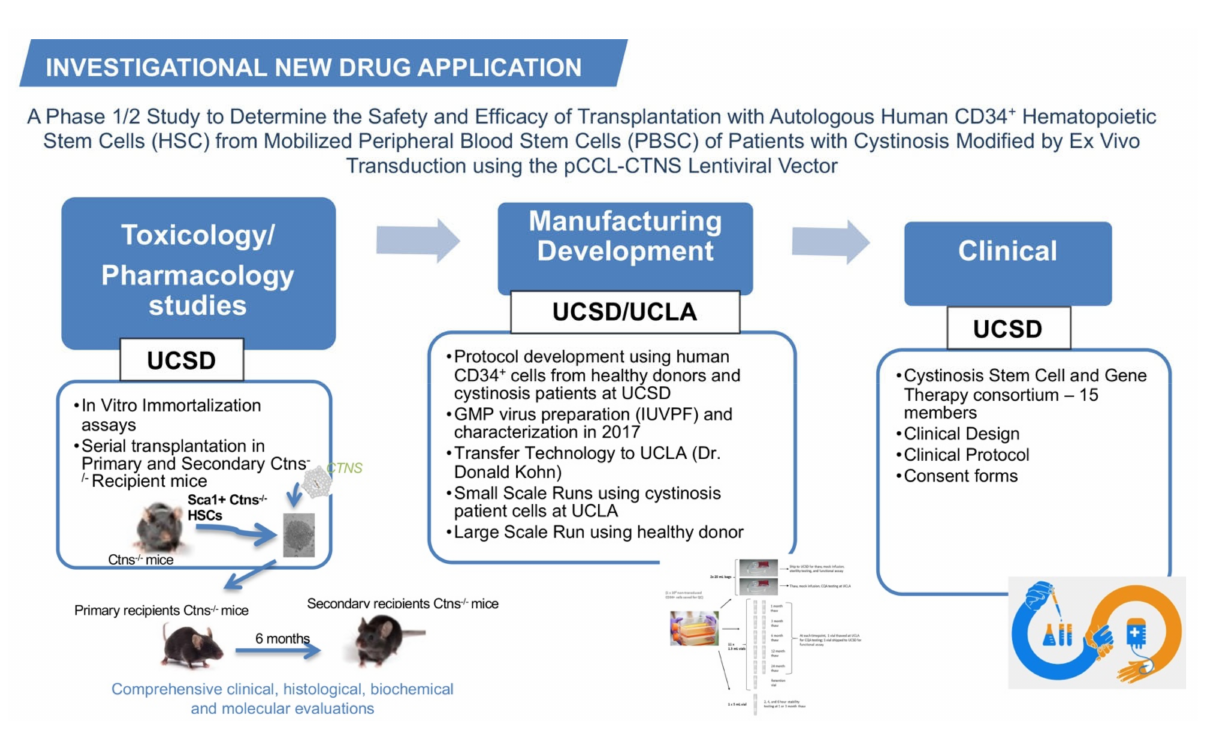
Figure 1. The investigational new drug application for cystinosis. The investigational new drug application contains three main categories, the toxicology/pharmacology studies, the manufacturing development, and the clinical design. The main studies performed in each category are listed in the